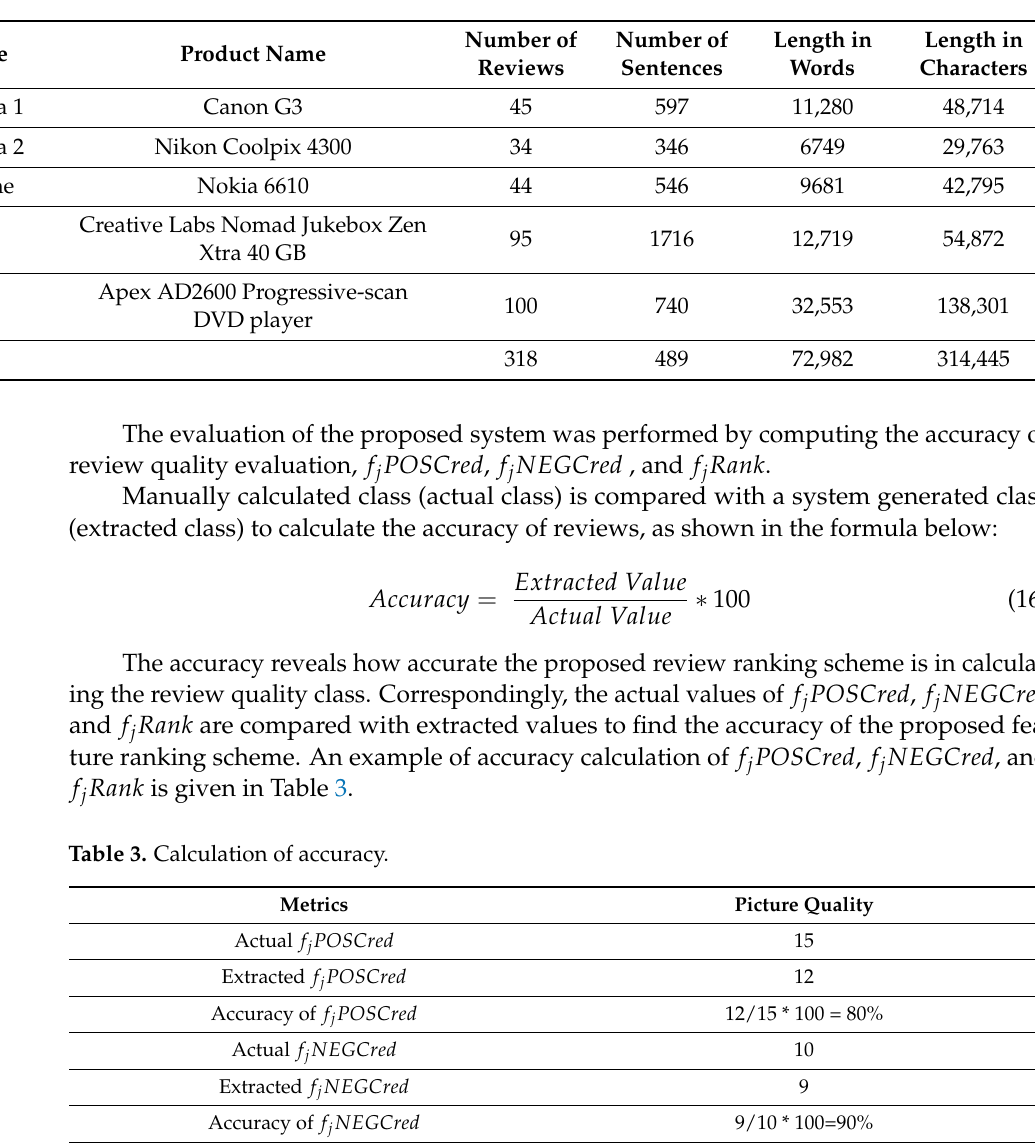
Table 2. Detailed information of dataset.